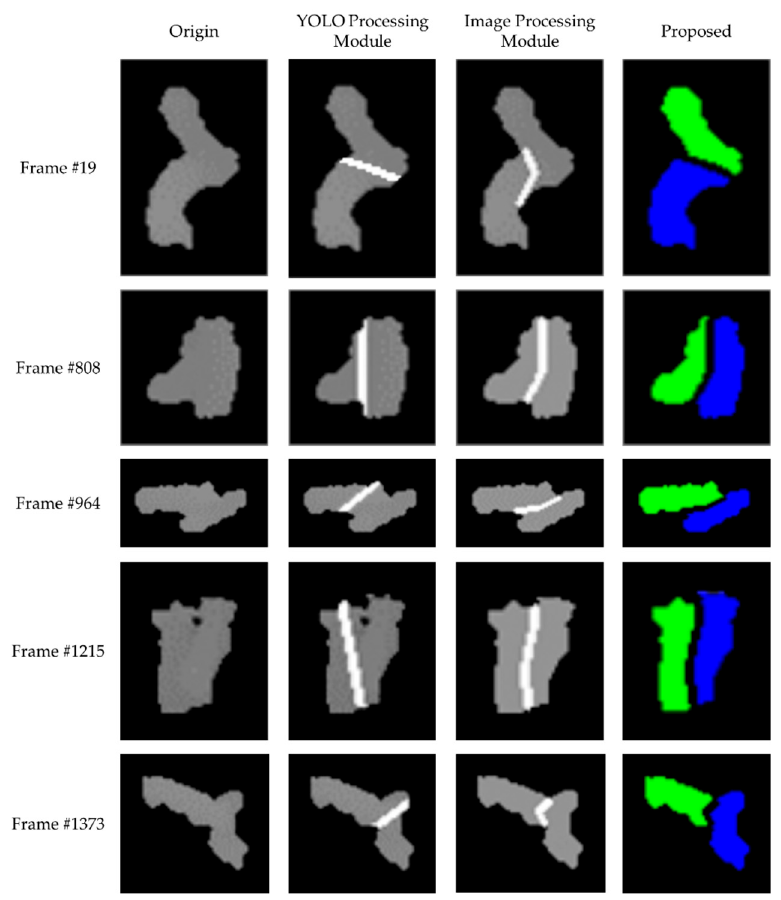
Figure 18. Comparison of the separation results with YOLO Processing Module and the Image Processing Module.